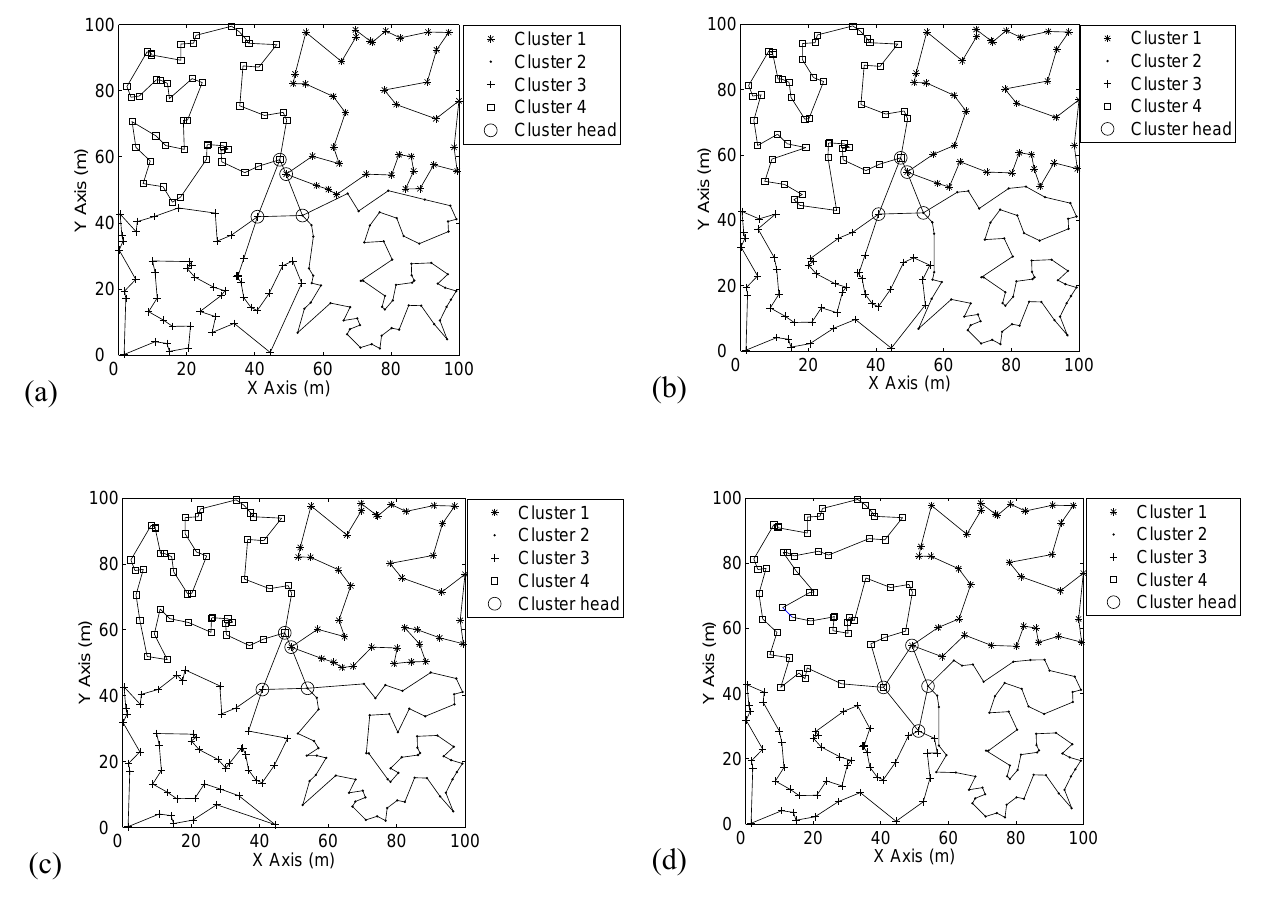
Figure 7. The routing and clustering results of (a) ACO-TSP, (b) SA-MTSP, (c) GA- MTSP, and (d) ACO-MTSP with the following parameters,